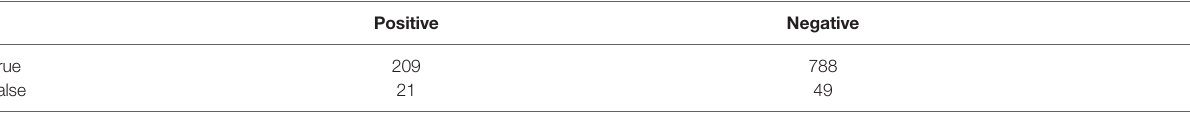
TABLE 3 | Validation of CTC recognition algorithm in clinical